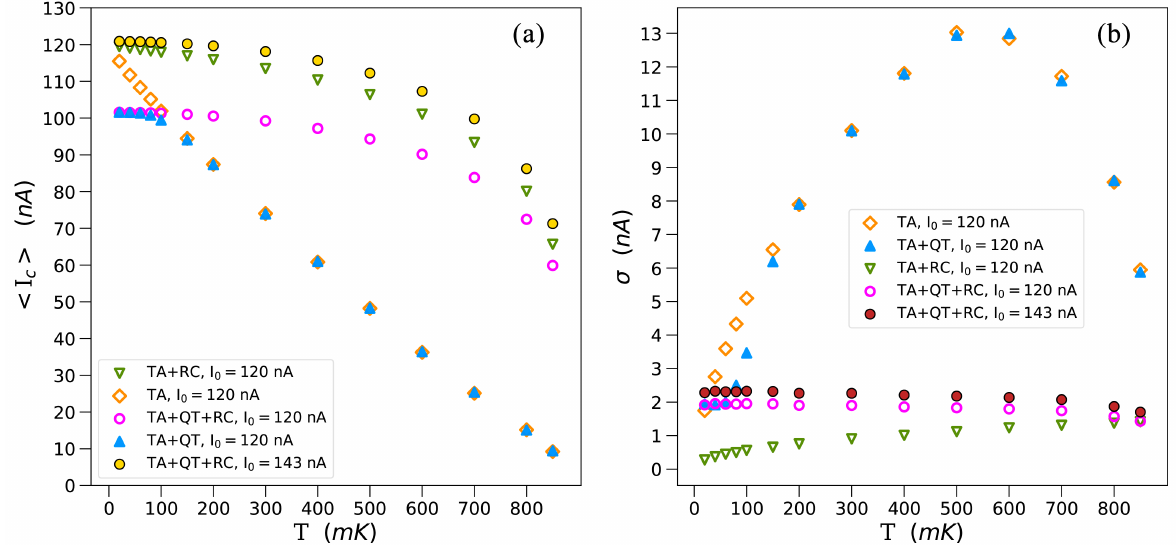
Figure 9. Mean switching currents ( a ) and widths ( b ) of the simulated data for different simulation parameters. In the legend, TA refers to thermal activation processes, QT to quantum tunneling, and RC to the dissipation effect due to the external circuit.